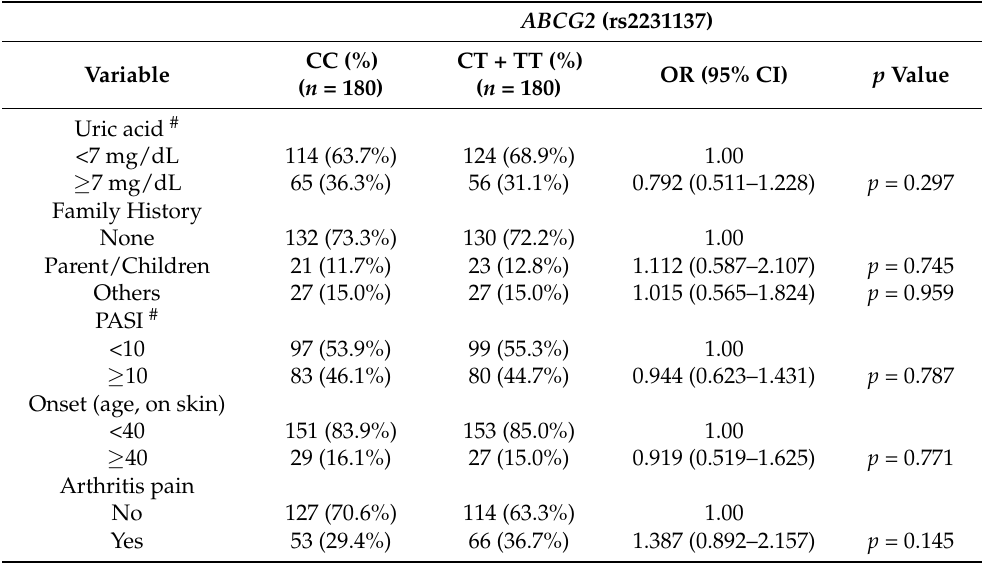
Table 4. Distribution of ABCG2 rs2231137 genotype frequencies and the clinical status among 410 patients with